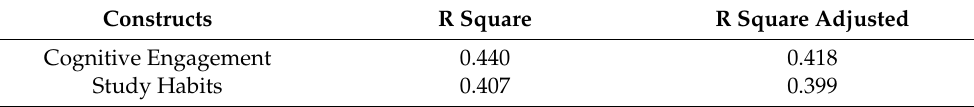
Table 5. R square.